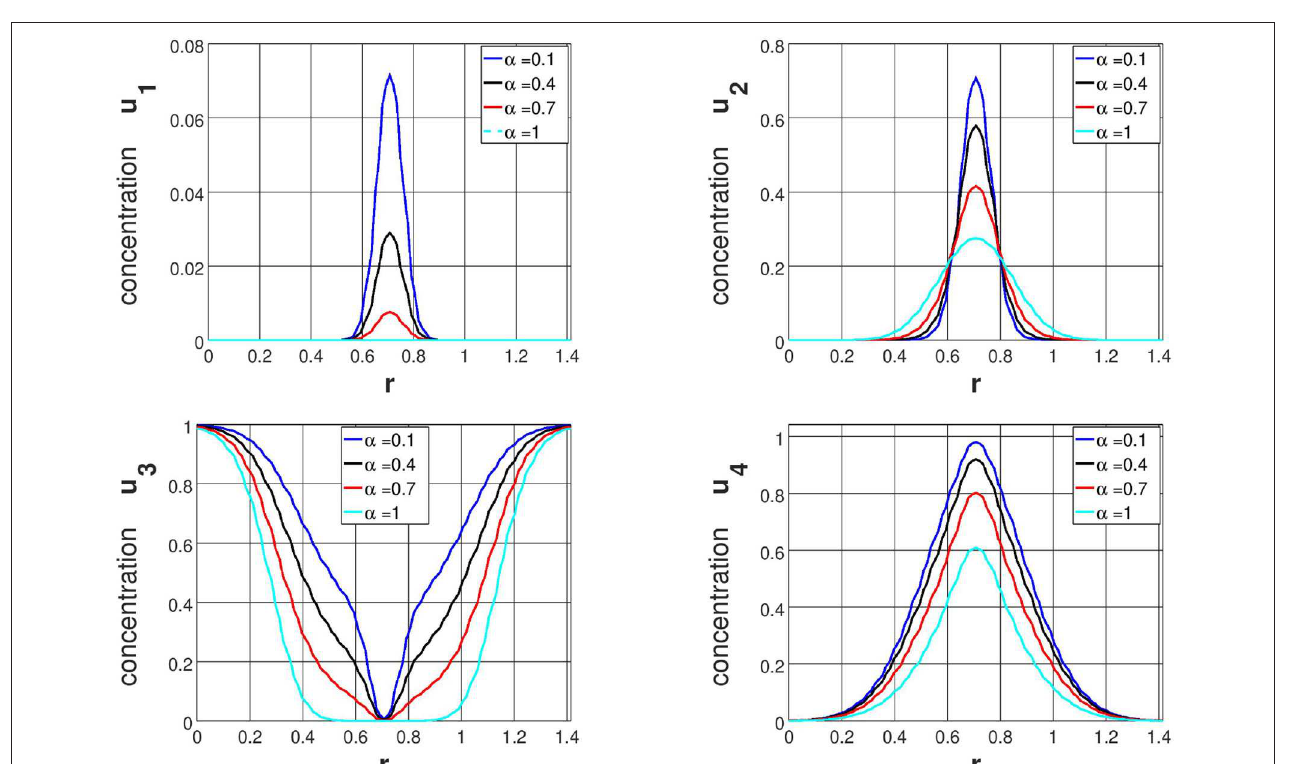
FIGURE 4 | Evaluation of u 1 , u 2 , u 3 , and u 4 at t = 10 along the line y = x .